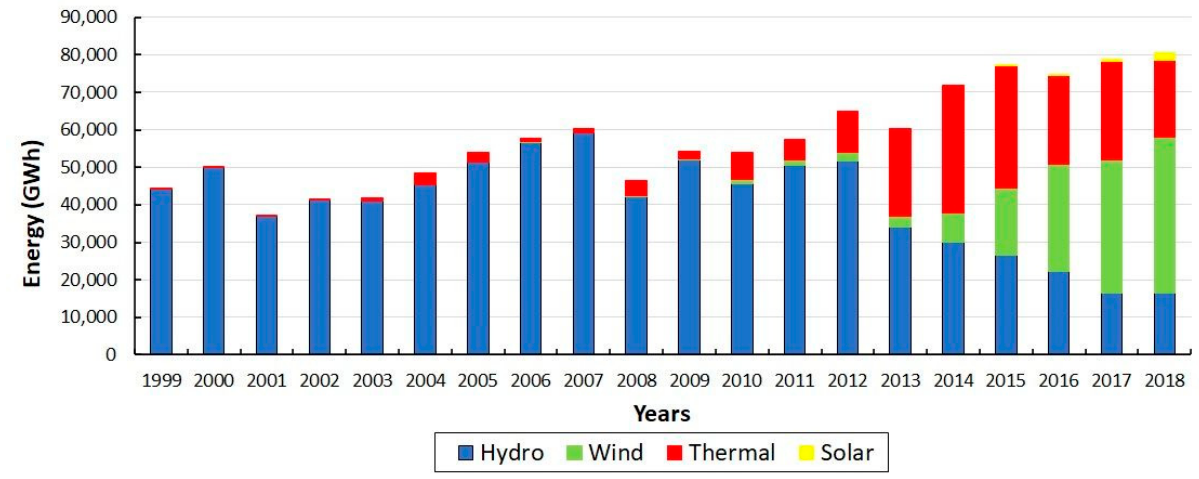
Figure 3. Generation of electric energy by type for the NBR. Data Source: [9].